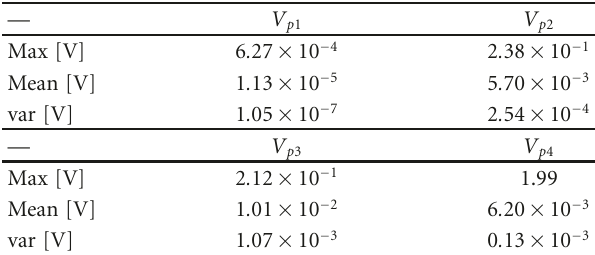
Table 6: Errors for simulation from Figure 8. The plate voltage signal errors are displayed.